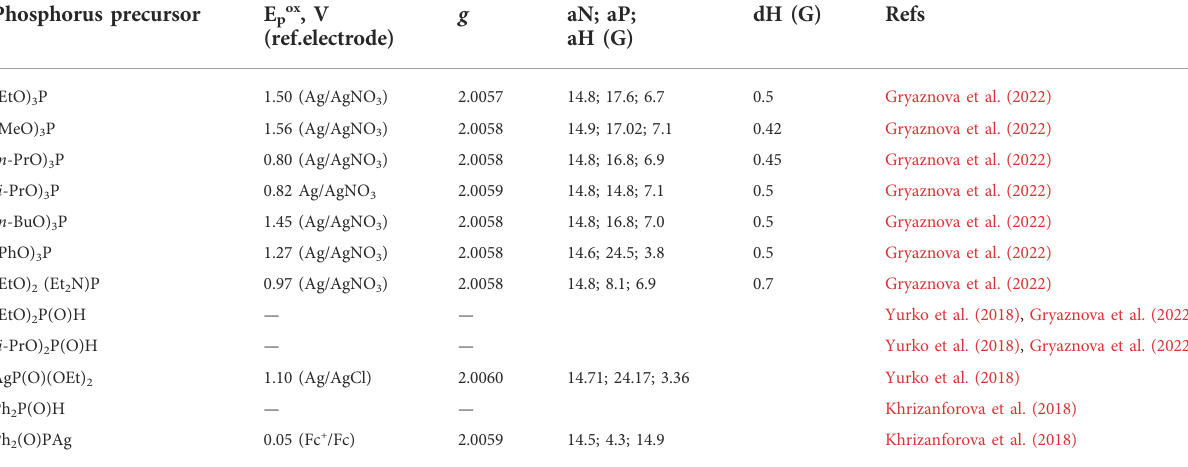
TABLE 1 Potentials of electrooxidation of phosphorus precursors and EPR parameters of phosphorus-centered radicalstrapped by the spin-radical trap N- tert -butyl- α -phenylnitrone (PBN). CH 3 CN. Phosphorus